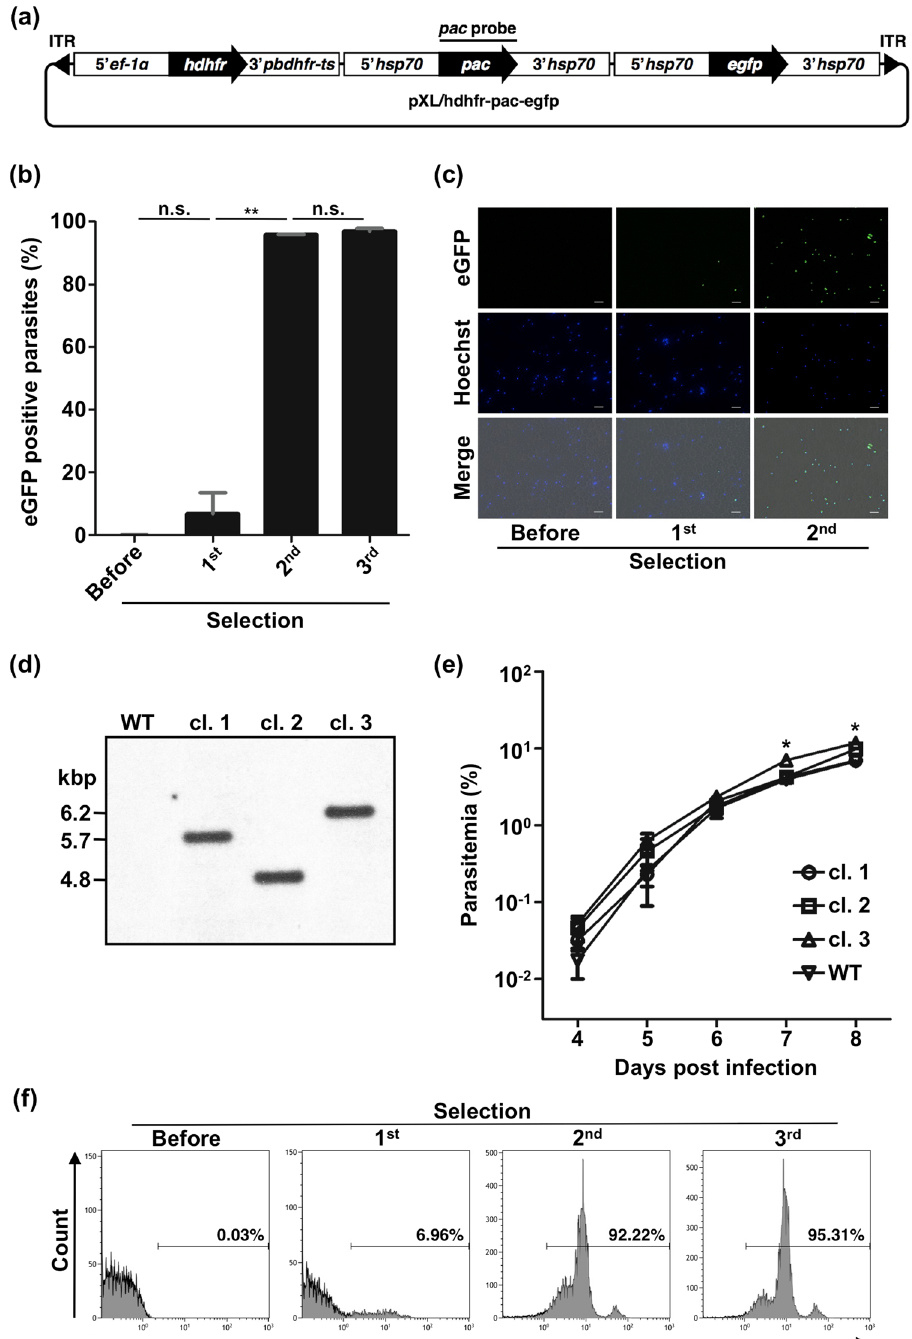
Figure 2. Generation of mutants using the pac marker and piggyBac transposon. ( a ) Schematic diagram of the piggyBac transposon vector containing hdhfr , pac and egfp expression cassettes (pXL/hdhfr-pac-egfp). This plasmid was also used in the experiment of Figs 1 and 6. ITR: inverted terminal repeat. ( b ) eGFP-positive parasite ratio after each puromycin selection. The ratio was analyzed using fluorescence microscopy. Each bar represents the mean ± SD of three independent experiments. ** p < 0.01, n.s.: not significant (paired t -tests). ( c ) Fluorescence images of parasites after each selection. Parasites were stained with Hoechst 33342. The scale bar represents 10 µ m. ( d ) Southern blot analysis of three mutant clones. Genomic DNA was digested using Eco RV and hybridized with a pac probe. The predicted sizes of restriction fragments are shown. WT: wild type. cl.: clone. Full-length blot image is presented in Supplementary Figure S1. ( e ) Growth assay of three clones. cl.: clone. WT: wild type. * p < 0.05 (two-tailed unpaired t -tests). ( f ) Flow cytometry analysis of eGFP positive mutant ratio after each puromycin selection. Numbers above bracketed lines indicate percent parasites with eGFP